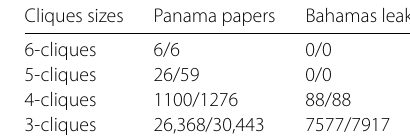
Table 3 Number of maximal/total k -cliques in the reduced networks